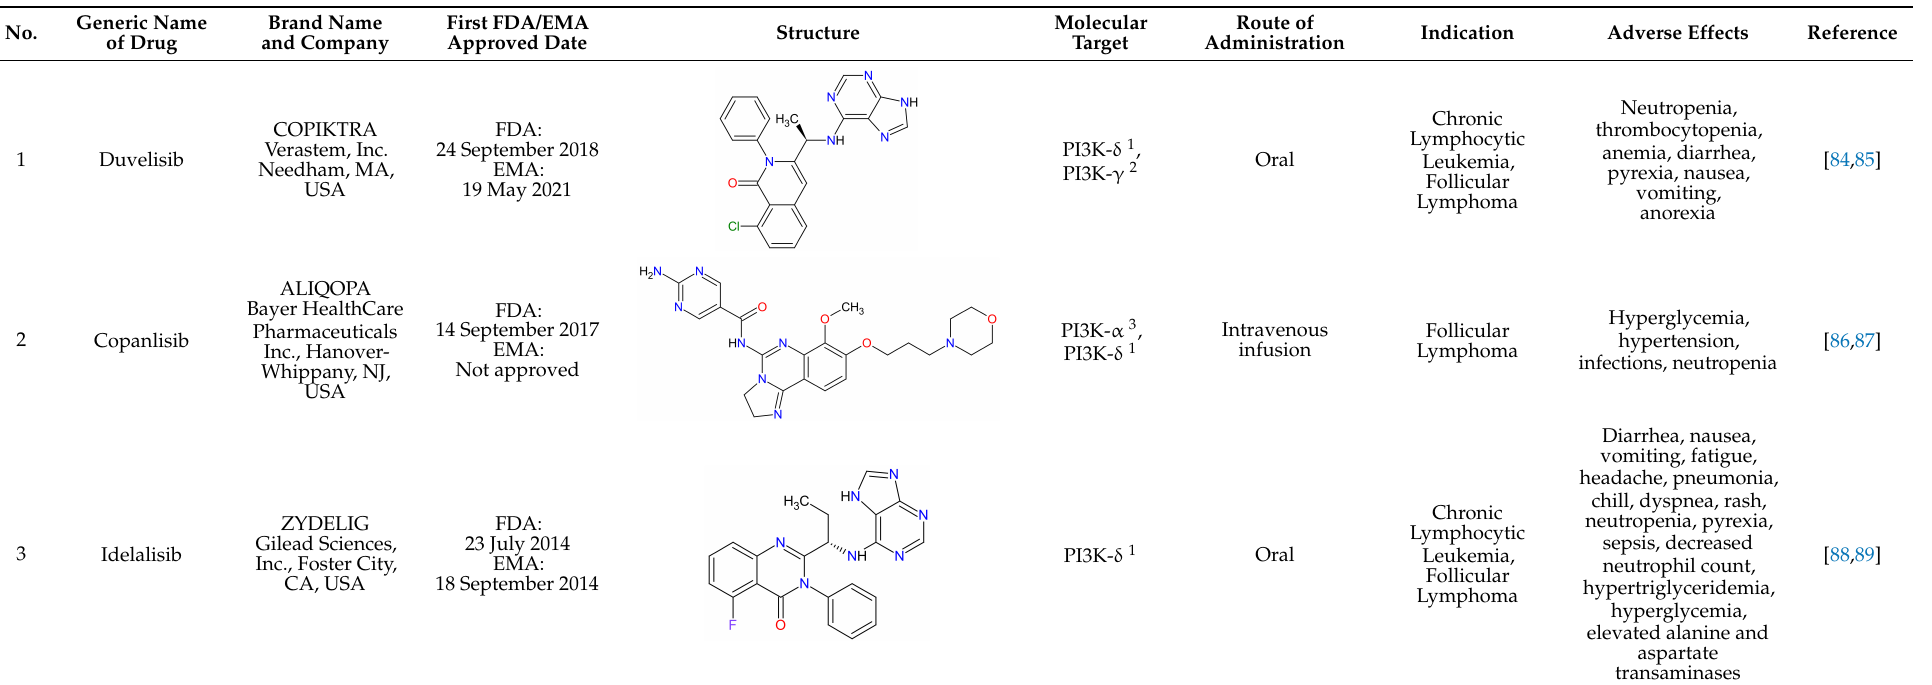
Table 3. Features of the phosphatidylinositol-3 kinase (PI3K) inhibitors approved by the Food and Drug Administration (FDA) from 2011 to 2021. The order of drugs is tabulated in order of most recent to oldest registration